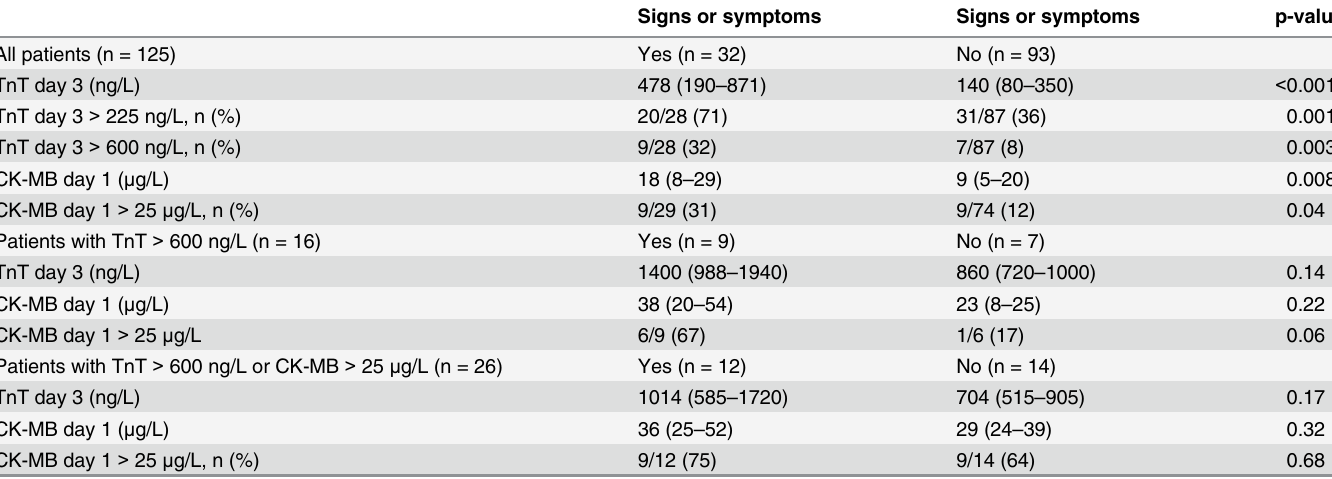
Signs or symptoms Signs or symptoms p-value